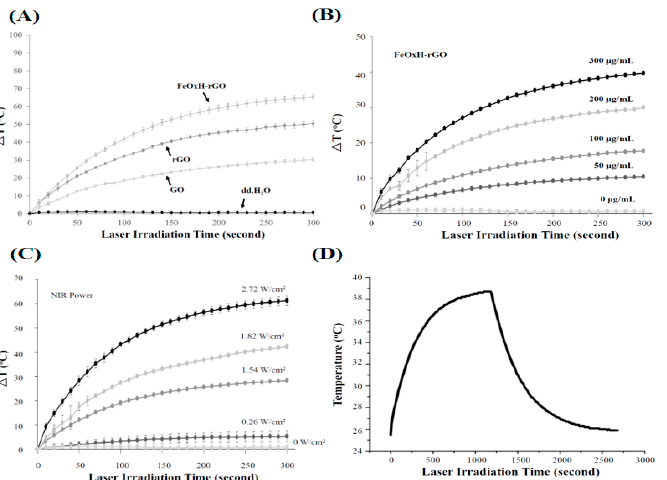
Figure 2. Photothermal properties of FeOxH–rGO nanocomposites. ( A ) Photothermal heating of dd. H 2 O, GO, rGO and FeOxH–rGO under NIR illumination (880 nm, 2.72 W/cm 2 ). ( B ) Photothermal heating of different concentrations of FeOxH–rGO (0–300 μ g/mL) under NIR illumination. ( C ) Photothermal heating of FeOxH–rGO (300 μ g/mL) under different intensities of NIR illumination (880 nm, 0–2.72 W/cm 2 ). ( D ) Photothermal conversion efficiency of FeOxH–rGO under NIR